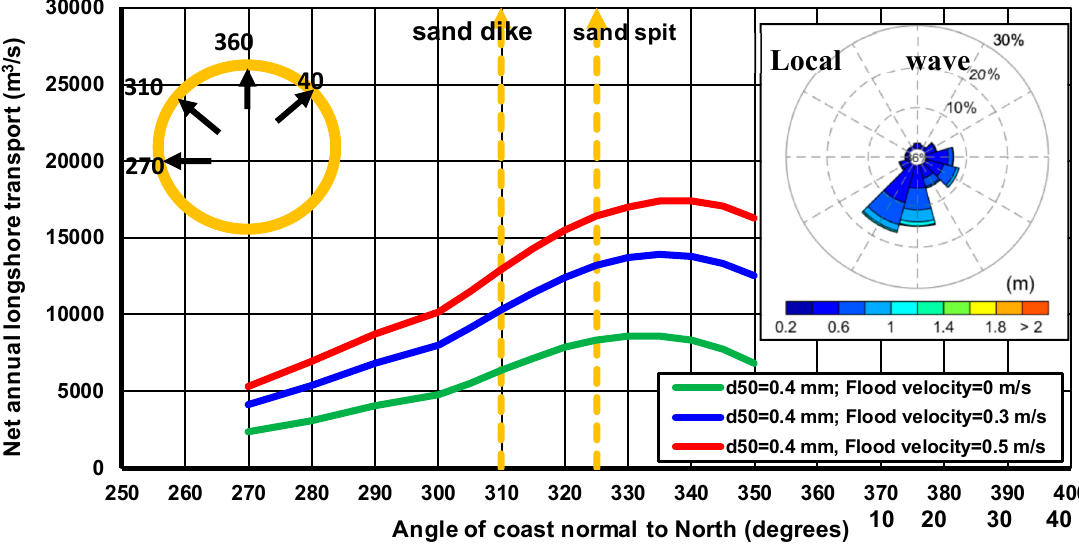
Figure 11. Net annual longshore transport at transects 15 and 30; the Littoral-model.